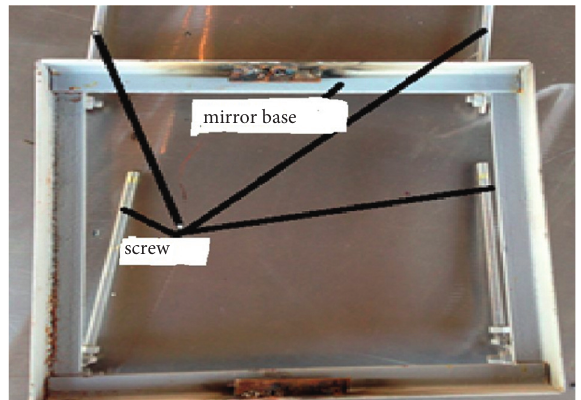
Figure 2: Mirror